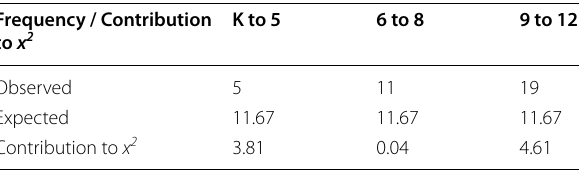
Table 6 Observed and expected frequencies between the emotional and the declarative and procedural